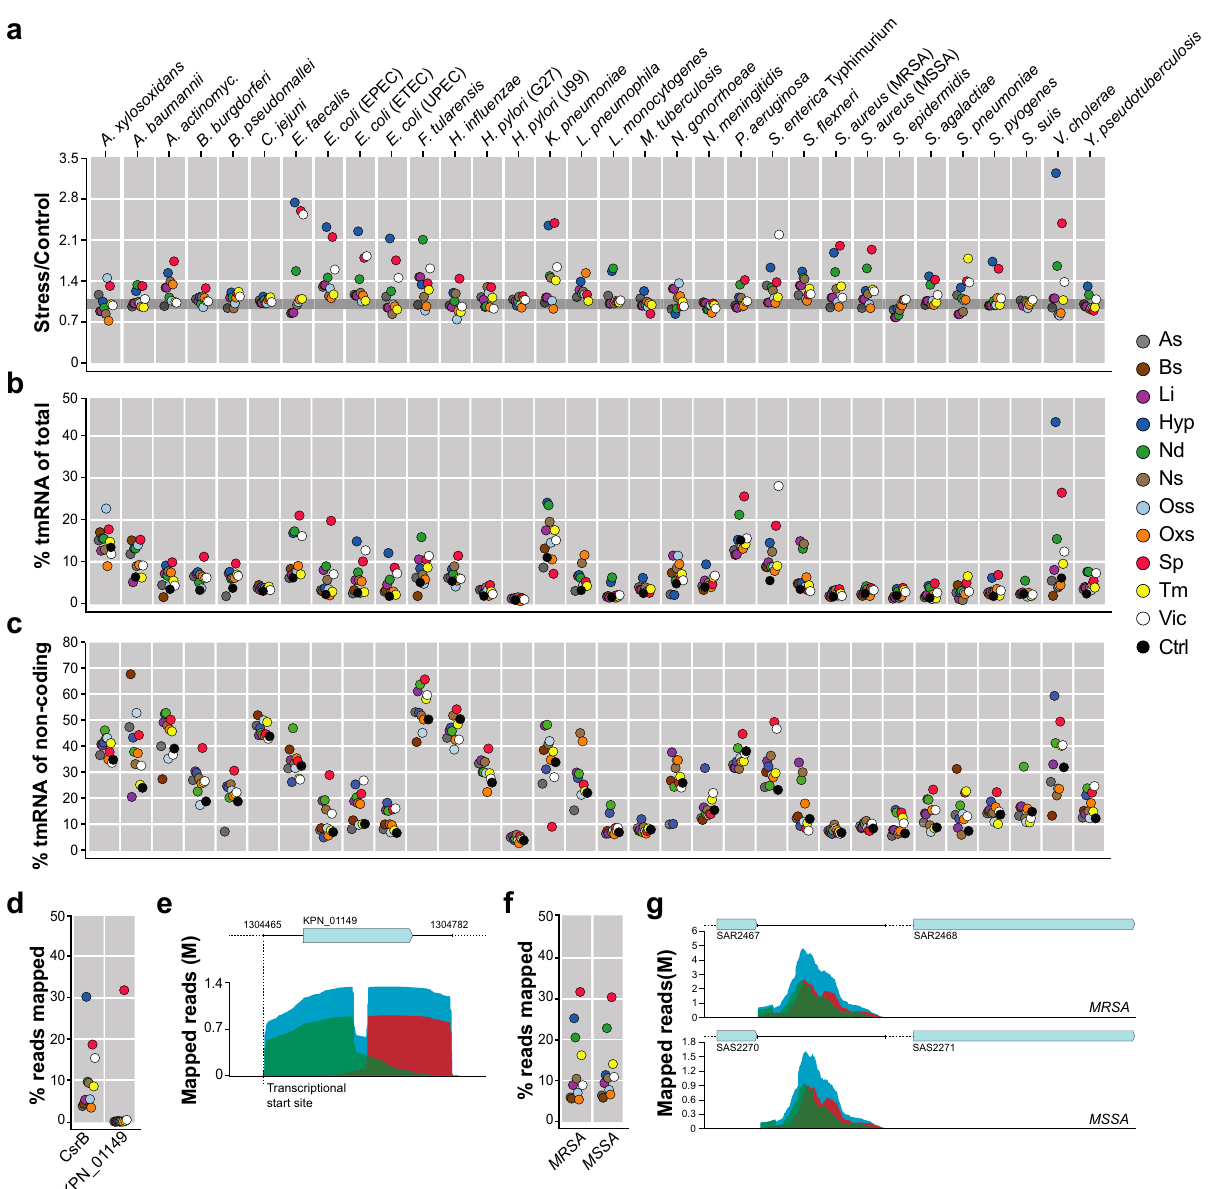
Fig. 5 Complex stress conditions commonly involve differential expression from non-coding regions. a Ratio of percent of reads mapped to non-CDSs under each stress condition in comparison to control for all tested strains. Different stress conditions are indicated by color (right). The gray line indicates Stress/Control value equal to one. b Proportion of reads mapped to tmRNA sequences of total number of mapped reads under each stress condition for all tested strains. c Proportion of reads mapped to tmRNA sequences of total number of reads mapped to non-CDSs under each stress condition for all tested strains. d Proportion of reads mapped to the K. pneumoniae CsrB and to the region covering KPN_01149 CDS with 5 ′ -UTR and 3 ′ -UTR sequences under each stress condition. e Number and alignments of reads mapped to KPN_01149 and its UTRs in stationary phase. Green indicates forward reads, red indicates reverse reads, and blue indicates paired reads. The vertical dashed line indicates the position of the TSS of KPN_01149 53 . f Proportion of reads mapped to SRS42 in S. aureus MRSA and MSSA genomes under each stress condition. g Number and alignments of reads mapped to SRS42 in S. aureus MRSA and MSSA strains in stationary phase. Colors represent reads as noted in e . Different stress conditions are indicated with colored dots on the right. The means of three replicates in each condition were used for the calculation in a – d , and f . Source data are provided as a Source Data fi